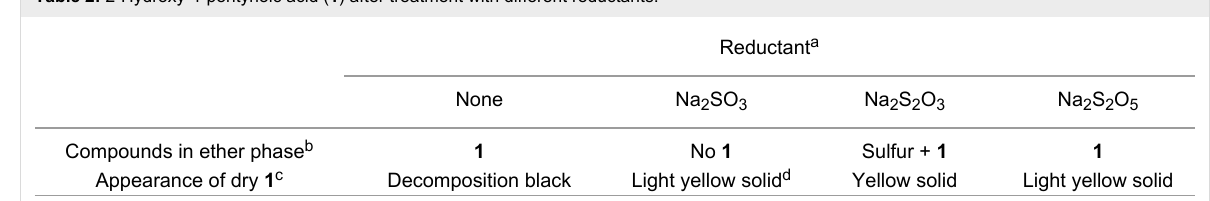
Table 2: 2-Hydroxy-4-pentynoic acid ( 1 ) after treatment with different